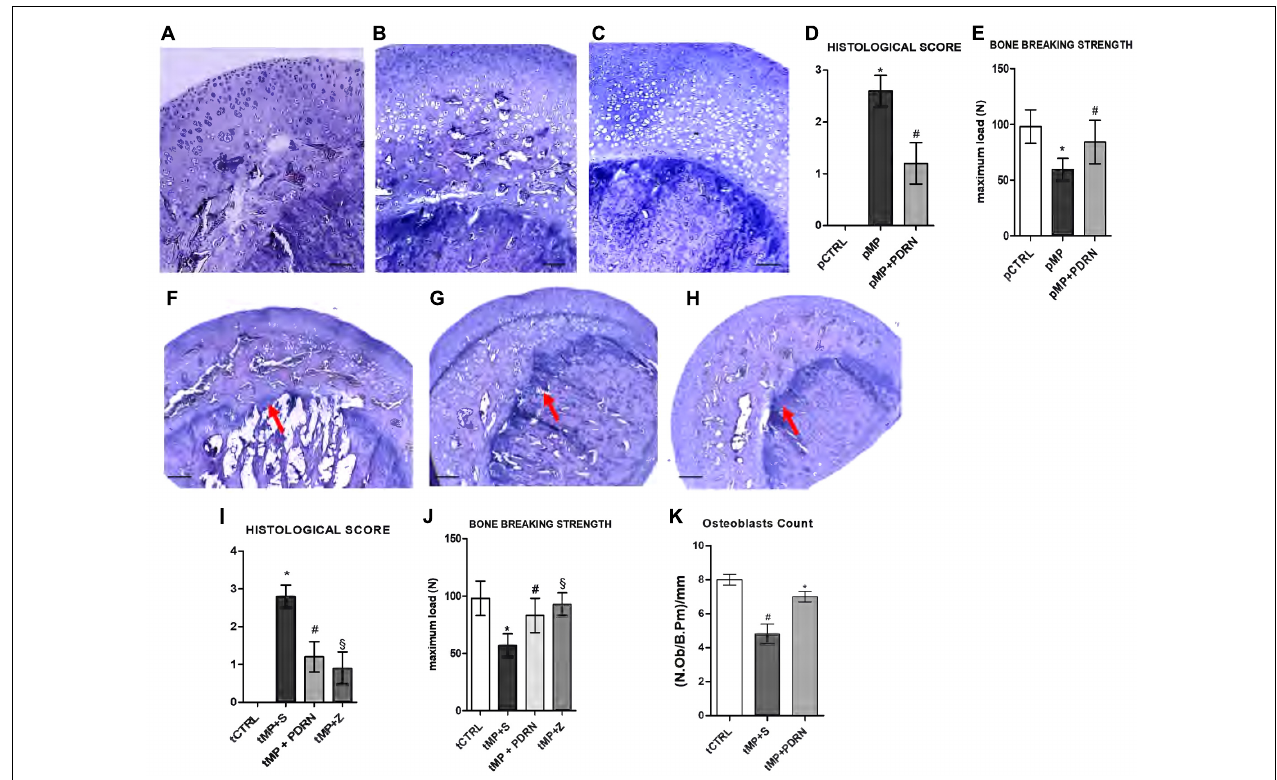
FIGURE 1 | Bone histology – prevention and treatment study. (A–C) Representative H&E staining of femur heads, scale bar 50 µ m. (A) pCTRL, (B) pMP, (C) pMP-PDRN. The graph in (D) represents the histological score; the graph in (E) the breaking strength for each group. ∗ p < 0.001 pMP vs. pCTRL; # p < 0.01 pMP+PDRN vs. pMP. Data are expressed as means and SD. (F–H) Representative H&E staining of femur heads, scale bar 100 µ m. (A) tMP+S, (B) tMP+PDRN, (C) tMP+Z. The arrows point at the metaphyseal cartilage. The graph in (I) represents the histological score; the graph in (J) the breaking strength for each group. ∗ p < 0.001 tMP+S vs. tCTRL; # p < 0.01 tMP+PDRN vs. tMP+S; § p < 0.01 tMP+Z vs. tMP+S. (K) Osteoblasts count, expressed as number of osteoblasts per mm of bone perimeter. ∗ p < 0.05 vs. tMP+S; # p < 0.05 vs. tCTRL. Data are expressed as means and